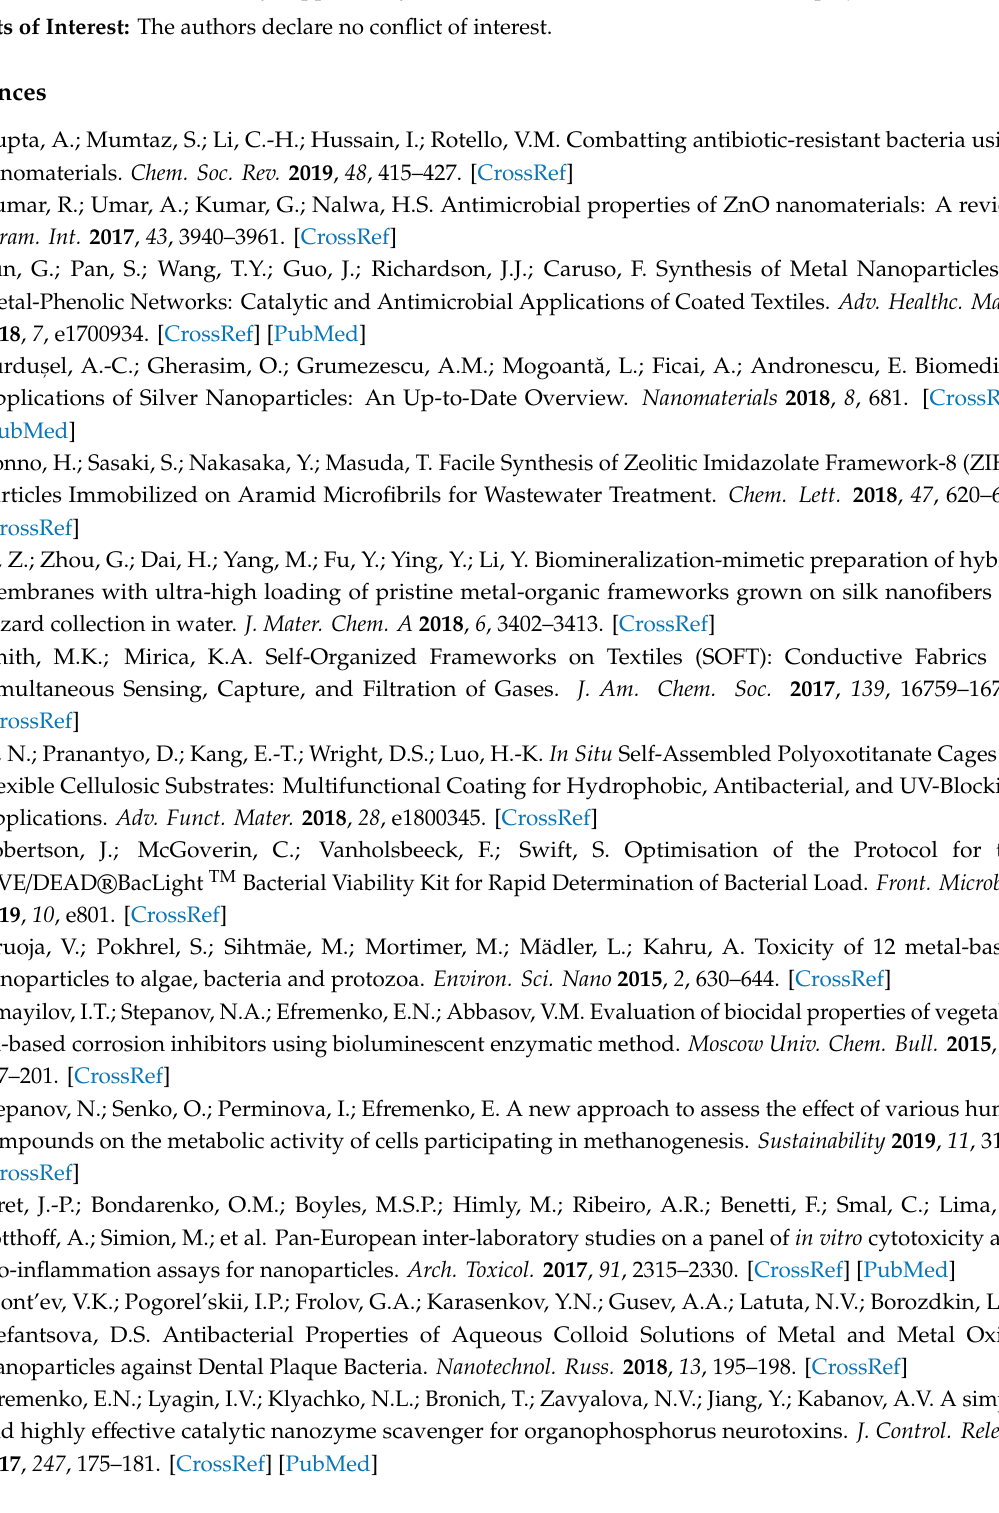
di ff erent nanoparticles, Figure S10: Growth inhibition of Staphylococcus aureus subsp. aureus (ATCC 25178) under samples of various fiber materials deposited by di ff erent